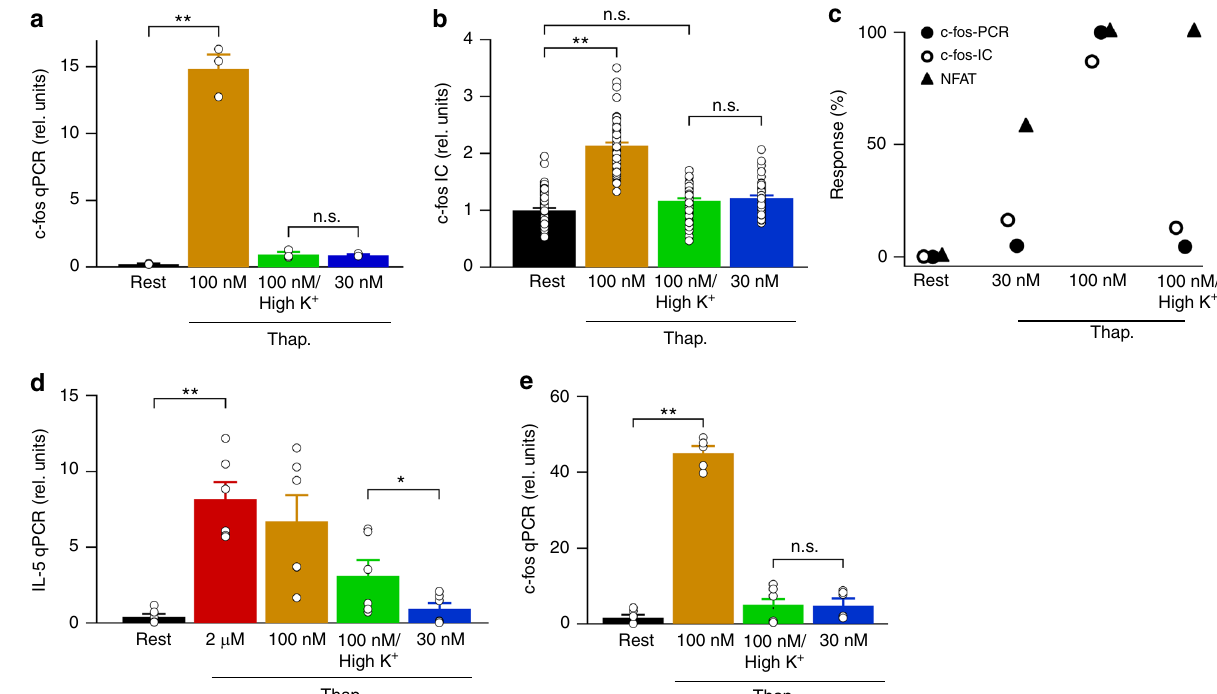
Fig. 4 C-Fos expression requires strong store depletion. a c-fos was measured using qPCR for the conditions shown. Cells were stimulated with thapsigargin for 40 min before mRNA was isolated. Data are mean of three independent experiments. b c-fos protein was quanti fi ed using immunocytochemistry. Each bar denotes > 56 cells. c Graph compares normalised c-fos and NFAT responses to the stimuli shown. C-Fos measurements using qPCR and immunocytochemistry (IC) are both shown. NFAT response was the nuclear/cytosolic ratio. Responses were normalised to those obtained after stimulation with 2 μ M thapsigargin. d Bar chart compares IL-5 transcription for the different conditions indicated. Rest denotes non-stimulated cells. Data are mean of four independent experiments. e Bar chart compares c-fos transcription for the conditions shown. Data are mean of three independent experiments. In panels d and e , cells were stimulated with thapsigargin and PMA (50 ng/ml). Rest denotes transcription in non-thapsigargin-treated cells but which had been exposed to PMA. *denotes p < 0.05, ** p < 0.01 and n.s. not signi fi cant, determined using unpaired Student ’ s t -test. Error